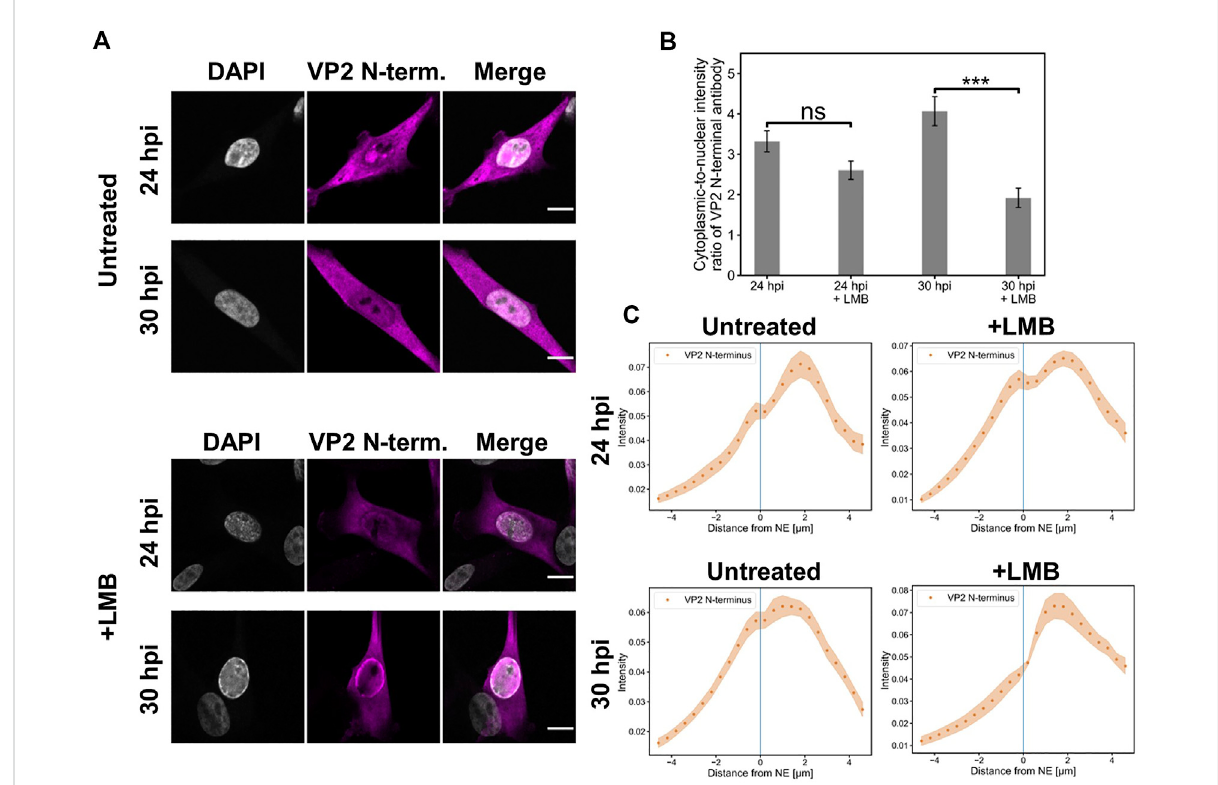
FIGURE 1 Full capsids egress the nucleus in the presence of leptomycin B (A) Representative confocal images of intracellular distribution of full (DNA- containing) capsids (magenta) and DAPI (blue) in NLFK cells in the presence and absence of LMB at 24 and 30 hpi. Capsids were detected with an antibody recognizing the N-terminal end of VP2 exposed outside the full capsids. LMB (100 ng/ml) was added at 10 hpi Scale bars, 10 µm. (B) Quantitativeanalysis showing thecytoplasmic-to-nuclear ratio of full capsids innon-treated and LMB-treated cells. The ratios were calculated from summed intensities of full capsid antibody in the cytoplasm and nucleus. Statistical signi fi cances were determined using Student´s t -test. The signi fi cancevaluesshownaredenotedas***( p < 0.01)andnon-signi fi cantasns( p > 0.05). (C) Nuclearandcytoplasmicdistributionoffullcapsidsas a function of increasing distance from the NE in the absence and presence of LMB at 24 and 30 hpi. The shaded areas around the data points represent the standard error of the mean ( n =